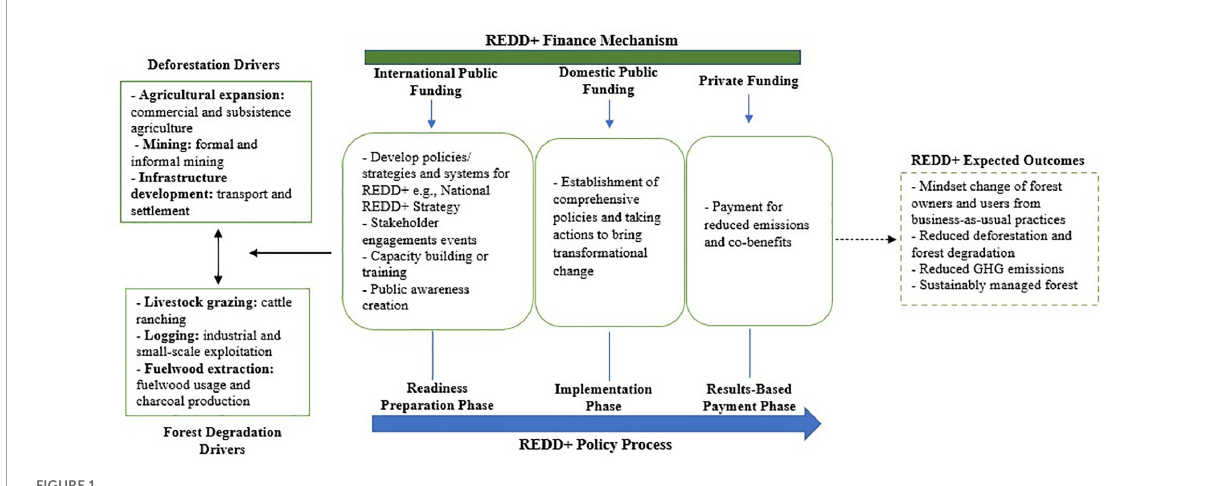
FIGURE1 Conceptual framework of the